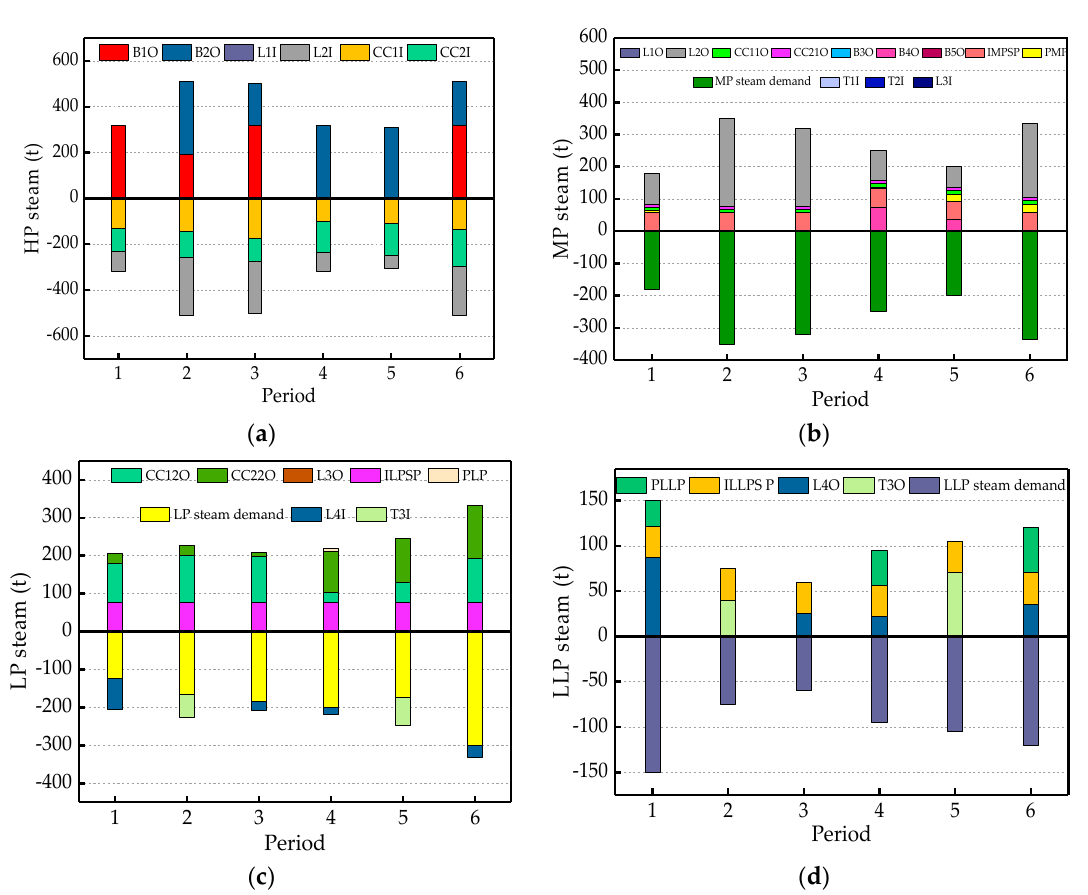
Figure 4. Optimal scheduling results for steam: ( a ) high-pressure steam; ( b ) medium pressure steam; ( c ) low-pressure steam; ( d ) low and low-pressure steam. (I, O indicate input and output of equipment, respectively.).